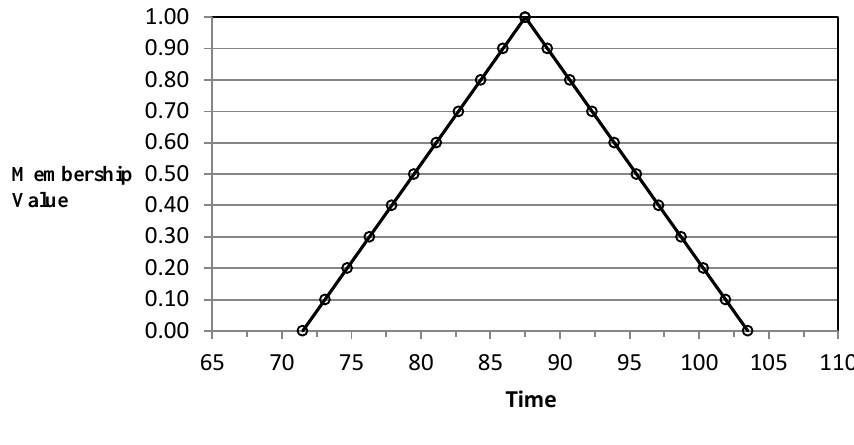
Figure 2. TFN of travel time.